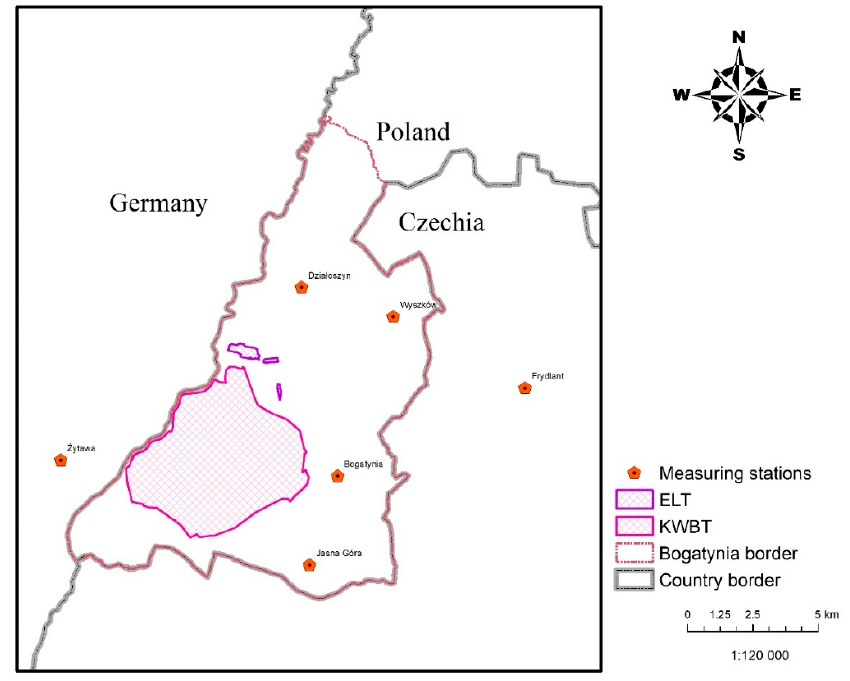
Figure 5. Location of measuring stations (source: own study).